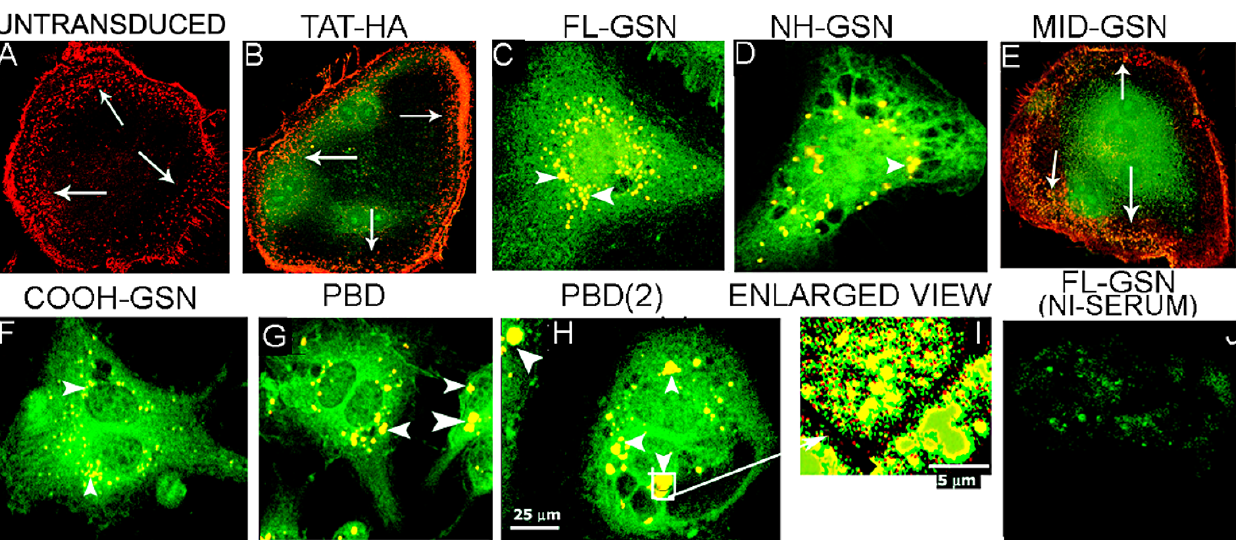
Figure 6 The effects of TAT-HA proteins transduction on actin distribution Confocal microscopy images of mouse osteoclasts stained for actin (red) and HA-protein (green) are shown. An actin enriched patch marked by a white square in Fig. H is magni- fied in Fig. I. Yellow color indicates the colocalization of transduced peptides with actin. Immunostaining with a non-immune (NI) serum is shown in Panel J. Scale bars- 25 µ m (Panels A-H and J) and 5 µ m (Panel. I). Arrowheads indicate patches enriched in transduced peptides and actin (Panels C, D, F, G, and H). Arrows indicate typical podosome structures in panels A, B, and E. The results shown are representative of three independent osteoclast preparations and